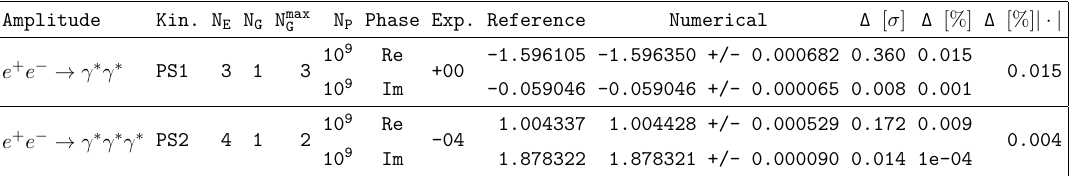
Table 8. Two one-loop amplitudes at physical kinematic points, whose ultraviolet and infrared singularities were subtracted with local counterterms. The reference results were calculated using Form [83] and Package-X